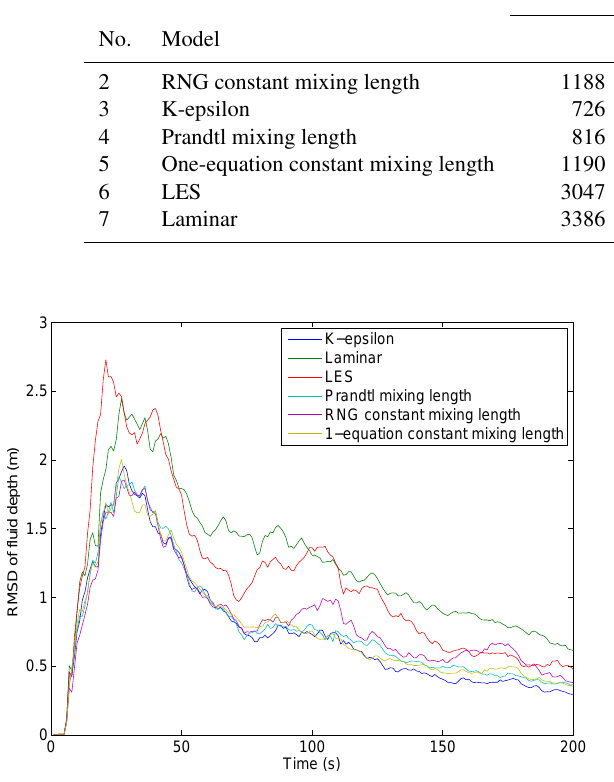
Figure 3. Root-mean-square deviation (RMSD) of fluid depth from the baseline model results (RNG dynamically computed mixing length) for each turbulence model as a function of